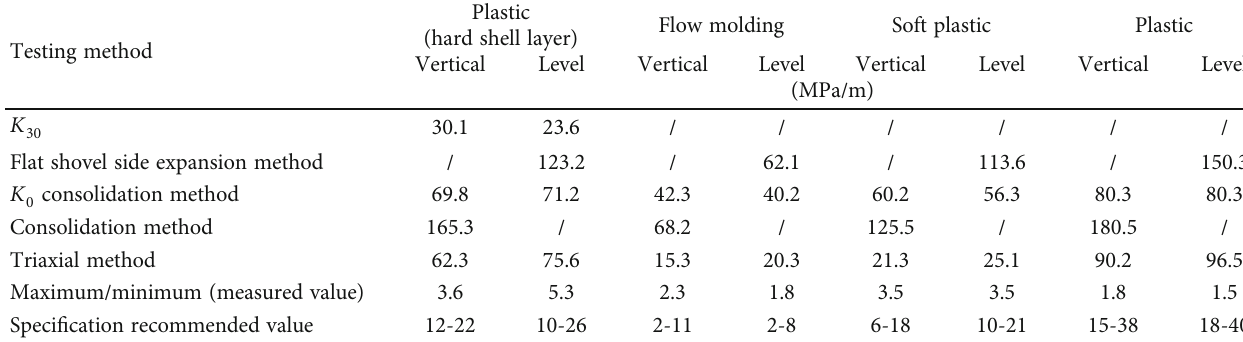
Figure 4: Indoor test apparatus. Table 3: Measured and corrected values of bed coe ffi